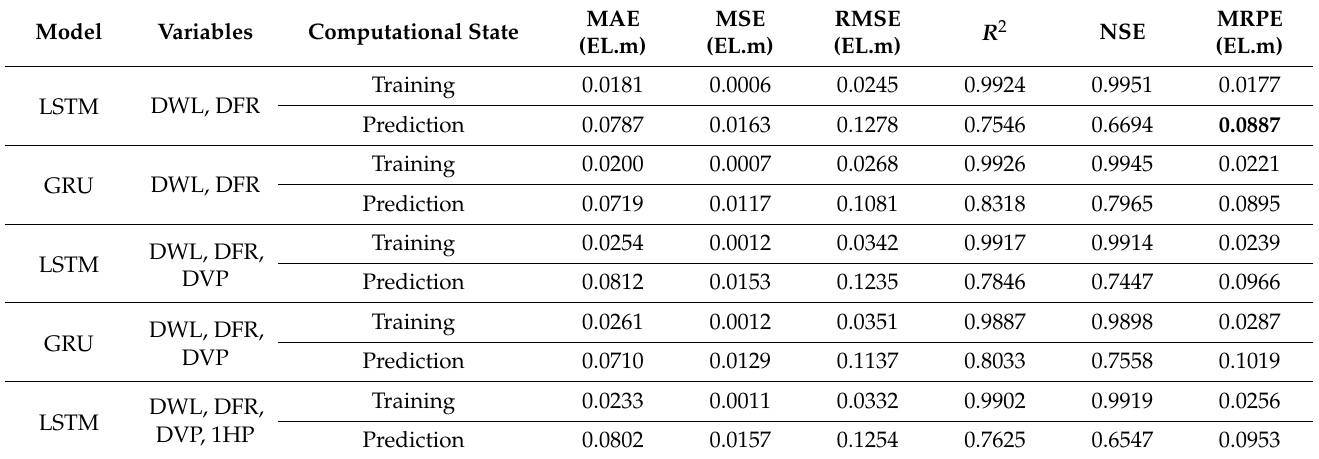
Figure 8. Observed and training total time-series water levels as multivariate input data: ( a1- )–( d1- ) LSTM; and ( a2- )–( d2- ) GRU. Table 10. Comparison of multivariate model